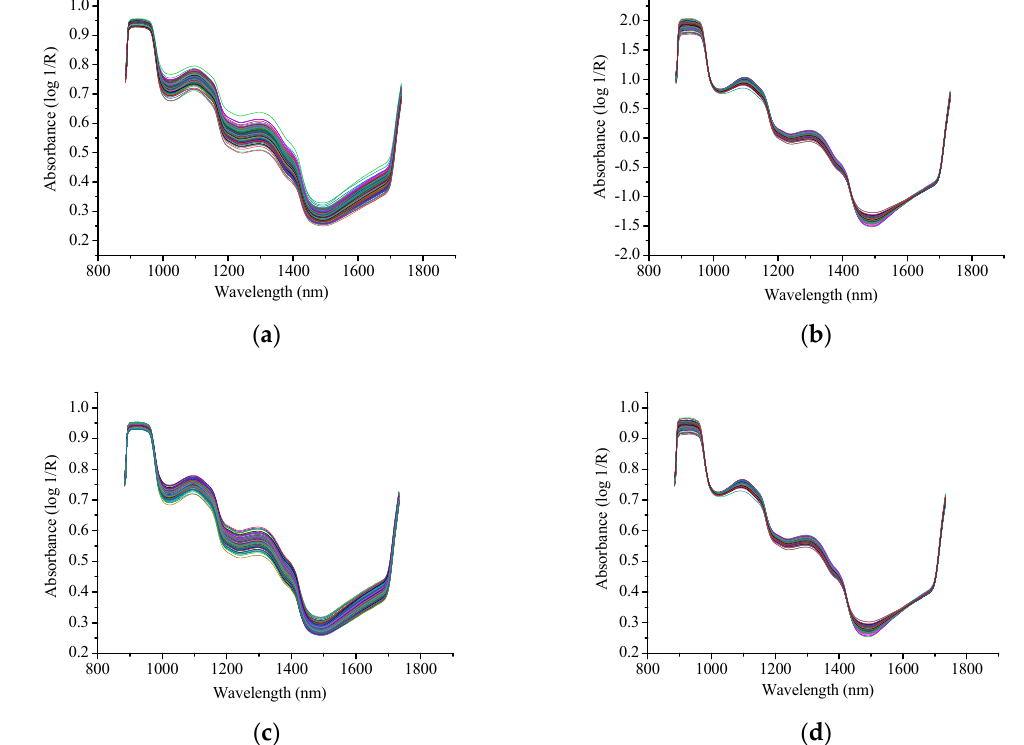
Figure 3. Spectra of all mango samples in full spectral range. ( a ) Raw spectra ( b ) Spectra preprocessed by SNV ( c ) Spectra preprocessed by S-G ( d ) Spectra preprocessed by MSC.